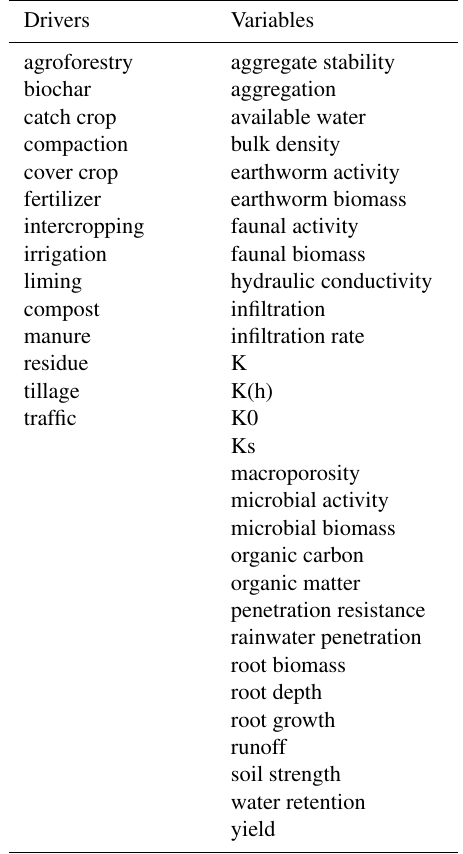
Table A1. Lists of drivers and variables used in the relationship